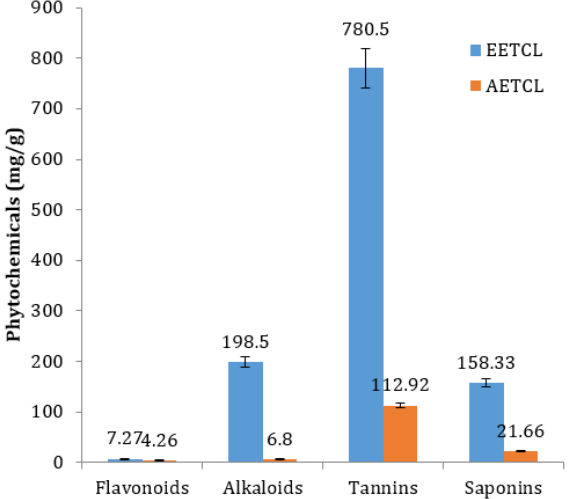
Figure 2. Antioxidant activities of Terminalia catappa leaf